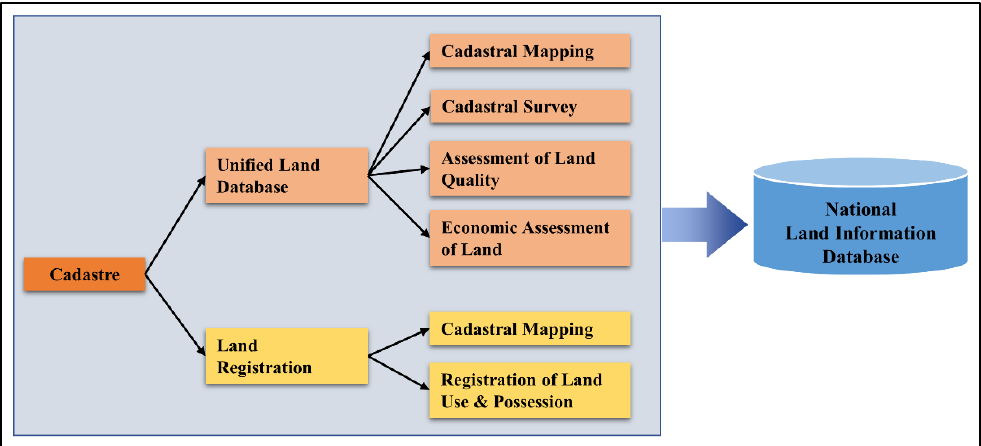
Figure 3. Cadastral activities in the context of land administration.